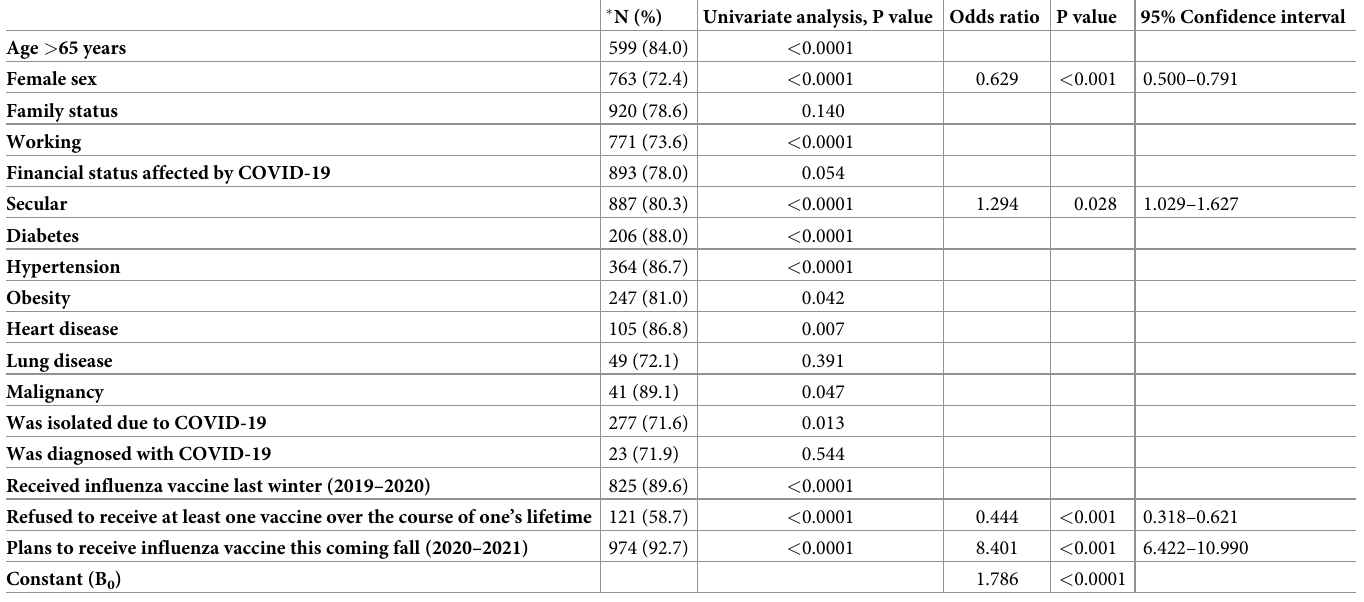
Table 4. Factors independently associated with plans to receive COVID-19 vaccine when